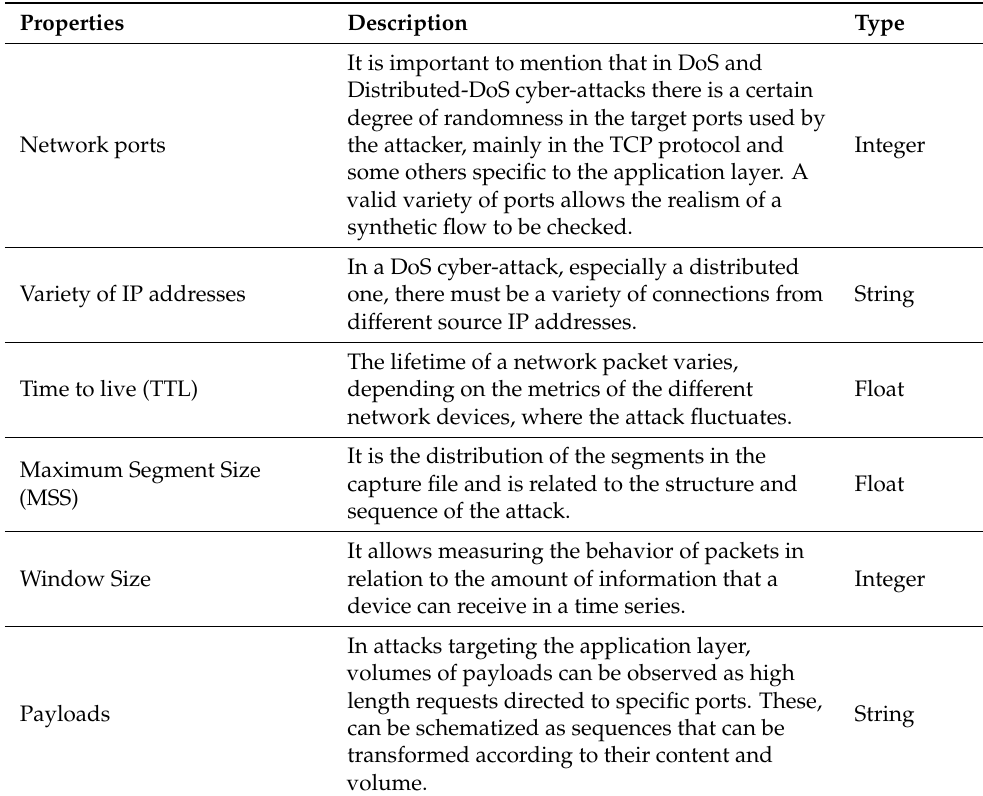
Table 3. Properties considered to generate a set of appropriate network